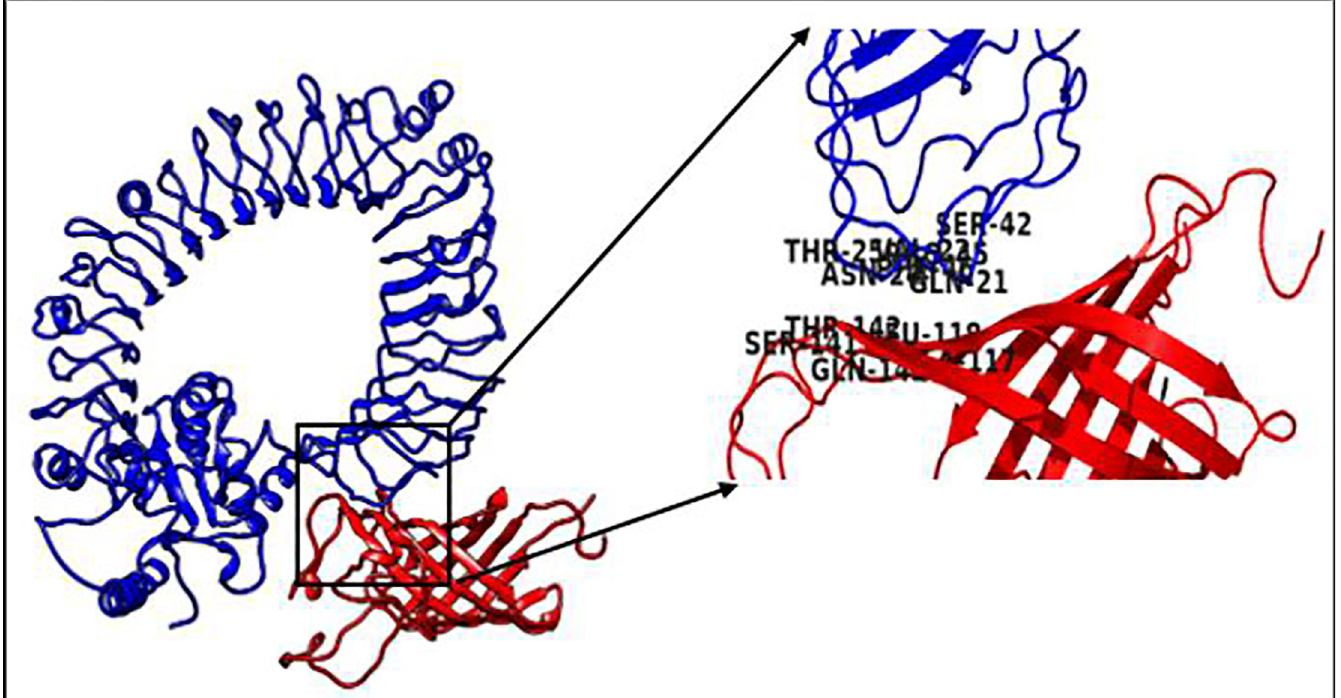
Fig 5. The molecular interaction of the vaccine and TLR5 receptor. The vaccine chain is highlighted in red and the toll like receptor in blue.